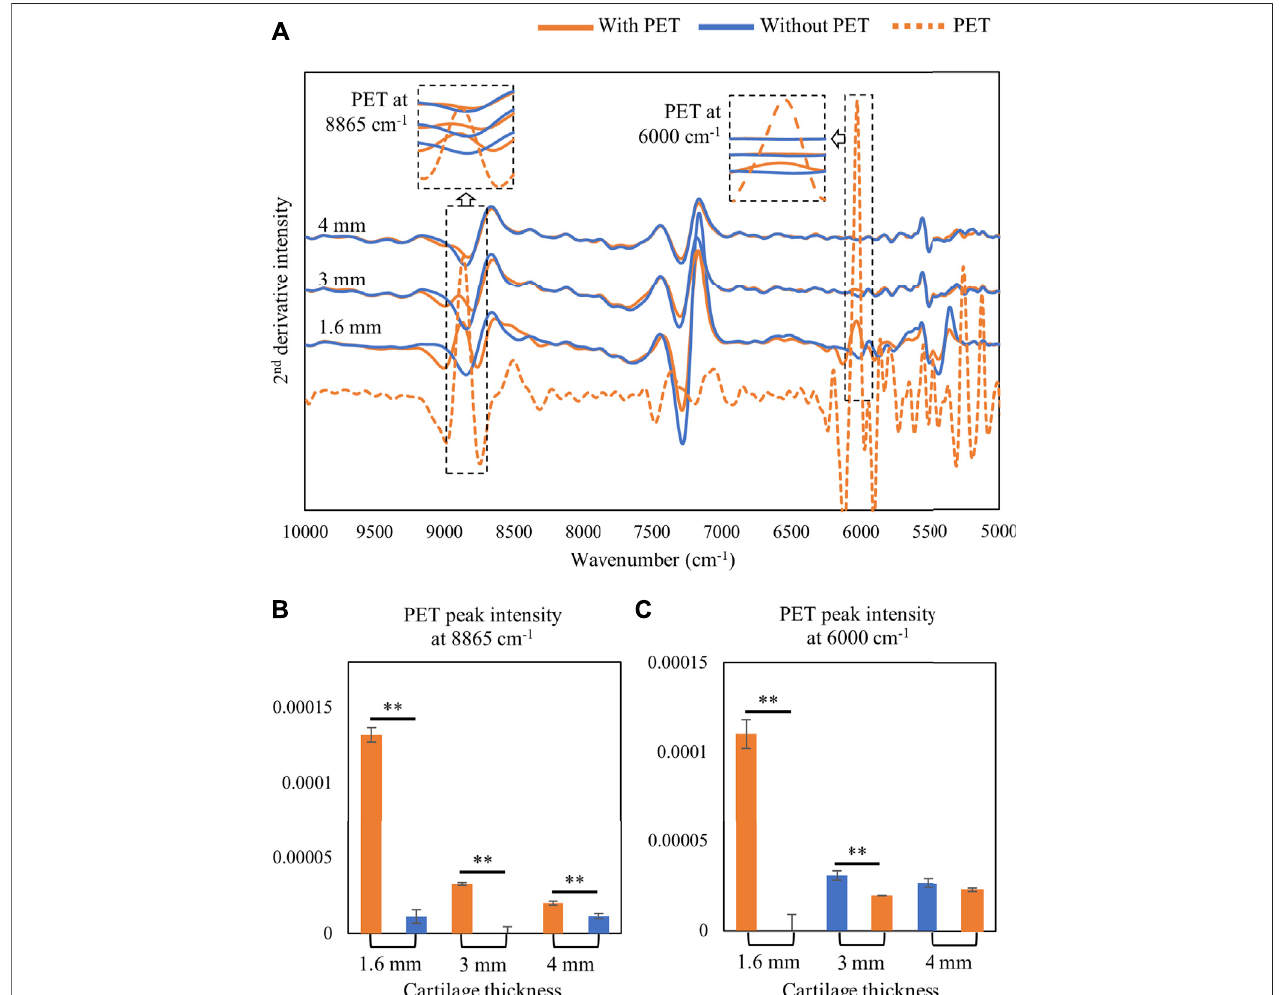
FIGURE 2 | (A) Second-derivative spectra of harvested cartilage tissue collected on top of a semi-in fi nite PET block or on Spectralon standard (without PET). The depth of detection of PET signal at higher and lower frequencies was monitored by assessment of the PET signal at 8865 cm − 1 and 6000 cm − 1 , respectively. (B) 8865 cm − 1 signal intensitycanbedetectedwithacartilagethickness ofupto4 mm. (C) 6000 cm − 1 PET signalintensitycanbedetected withacartilagethickness ofup to 3 mm only. pp p <